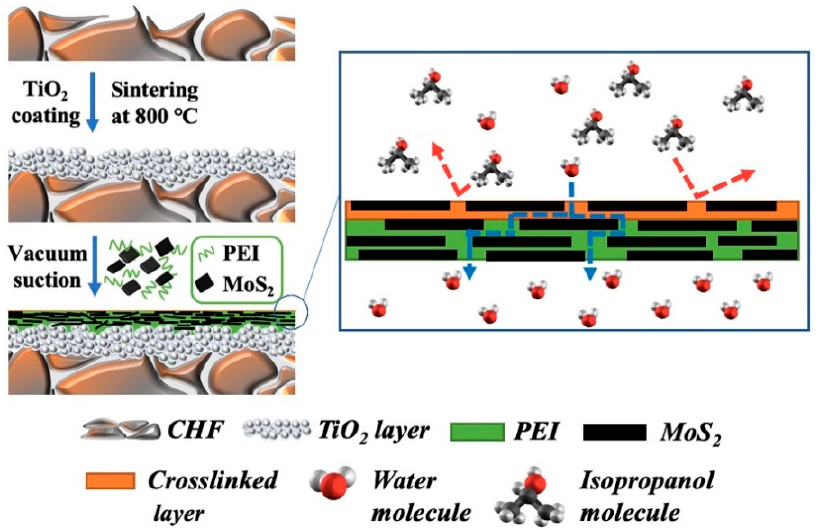
Figure 27. Schematic showing the arrangement of MoS 2 hybrid membranes atop ceramic hollow fibers for effective pervaporation-based dehydration of isopropanol solutions.